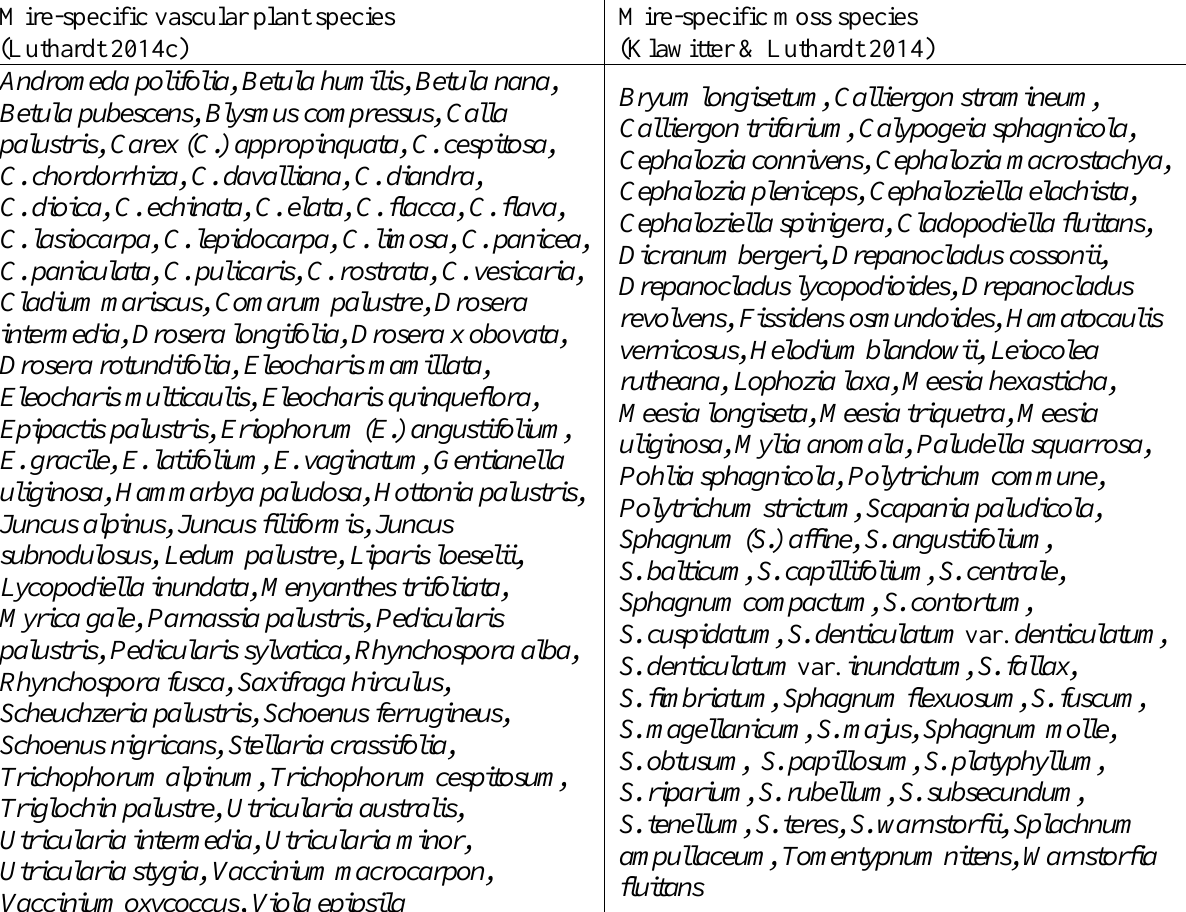
Table 2. Mire-specific vascular plant and moss species occurring in the federal state of Brandenburg (north- east